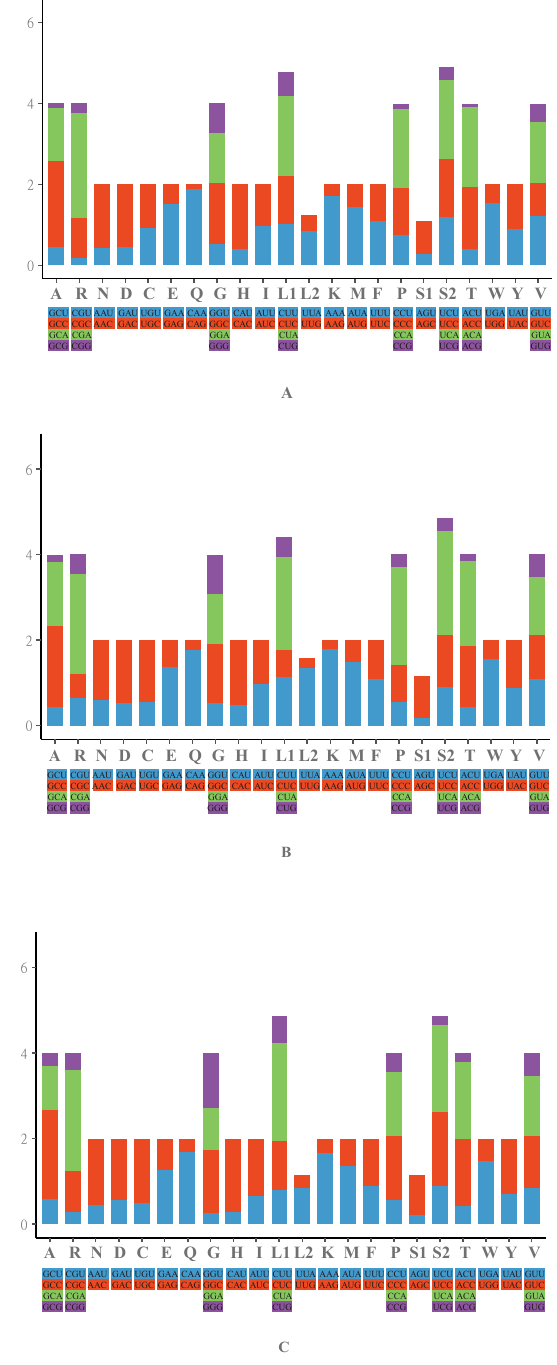
Figure 2. The relative synonymous codon usage (RSCU) of the mitochondrial genomes of I . gyldenstolpei ( A ), S . indicus ( B ), and T . hainanus ( C ). Acronyms stand for different amino acids. The x-axis represents all codons used and different combinations of synonymous codons, and the RSCU values are listed on the y-axis.